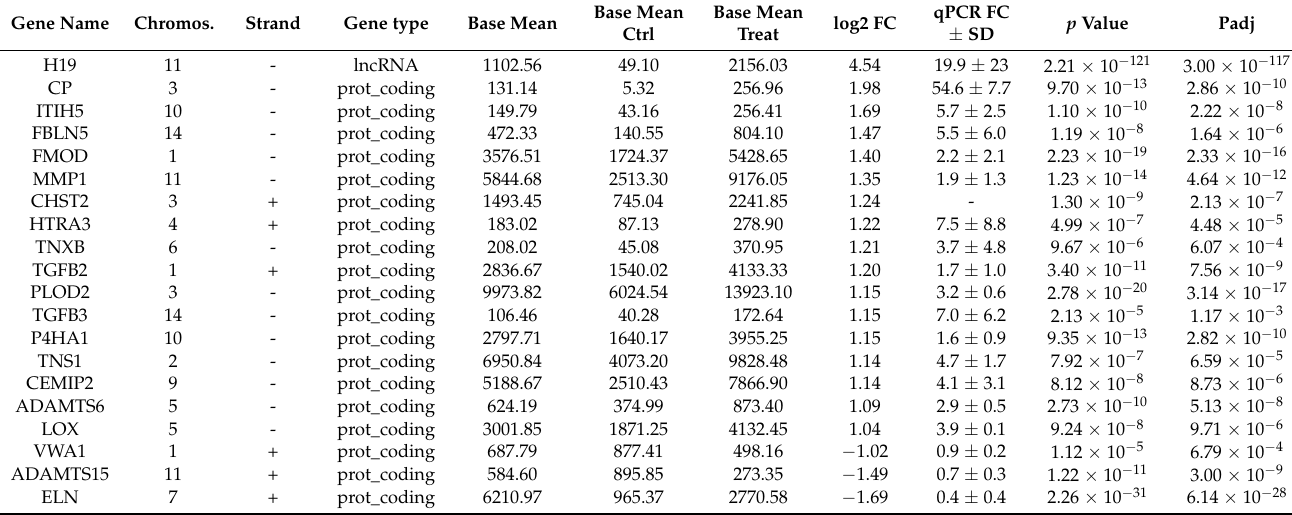
Table 2. List of 20 fibrosis-related genes significantly up-regulated or down-regulated (minus log2 FC) by hypoxia in LECs. The table contains gene annotations (name, chromosome, strand, and gene type), average expression in all samples (baseMean), control samples (baseMean Ctrl), and treatment samples (baseMean Treat), as well as statistics for the genes (log2-fold-change of RNASeq studies, p-values, and adjusted p -values). Also, qPCR validation is shown. For CHST2, primer design for qPCR did not reveal specific probes. For H19, design of exon spanning primers was not possible. FC = fold change; lncRNA = long non-coding RNA; SD = standard deviation.